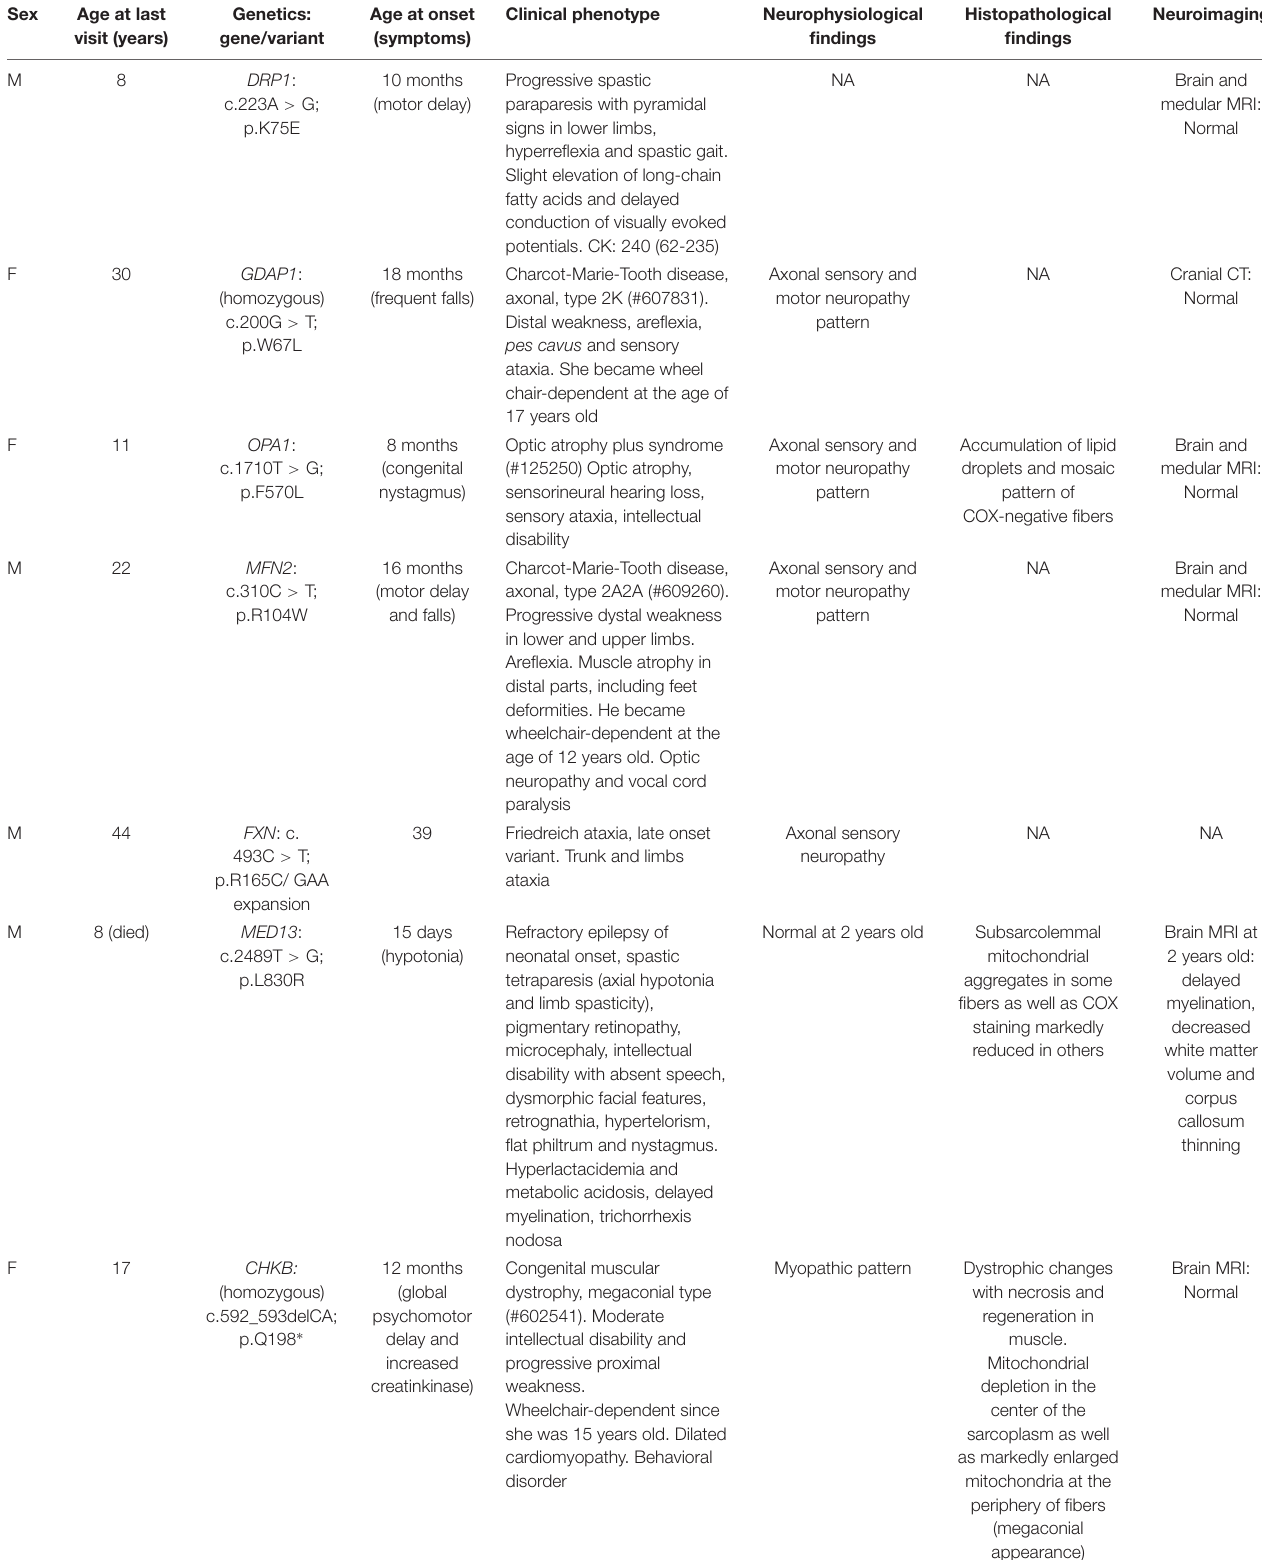
TABLE 1 | Summary of the clinical and genetic features in the patients of this